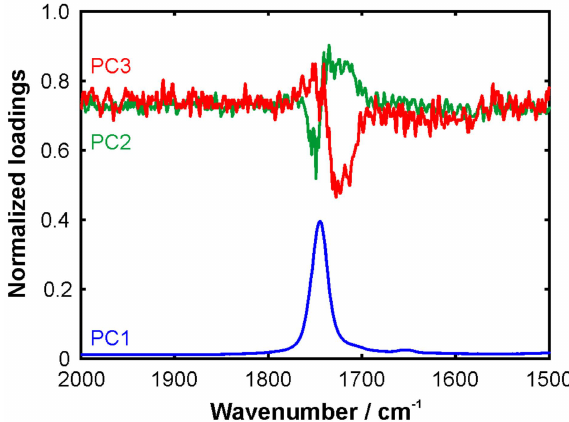
Figure 6. Loadings plot from the PCA of the passion fruit oil blends with sunflower oil showing the intensity normalized PCs 1–3 in the spectral range of the carbonyl stretching